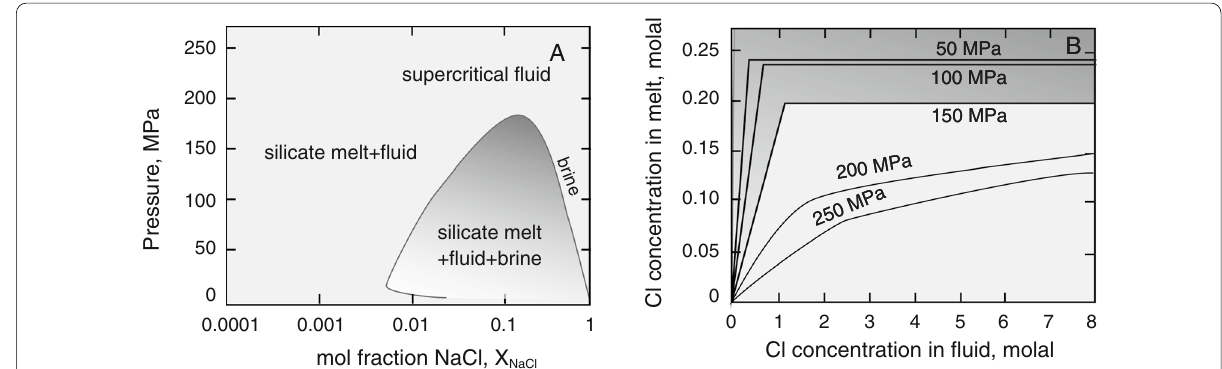
Fig. 4 Chlorine distribution between saline fluid and phonolitic magma, A . Fluid–melt equilibria with immiscibility gap as a function of NaCl concentration in